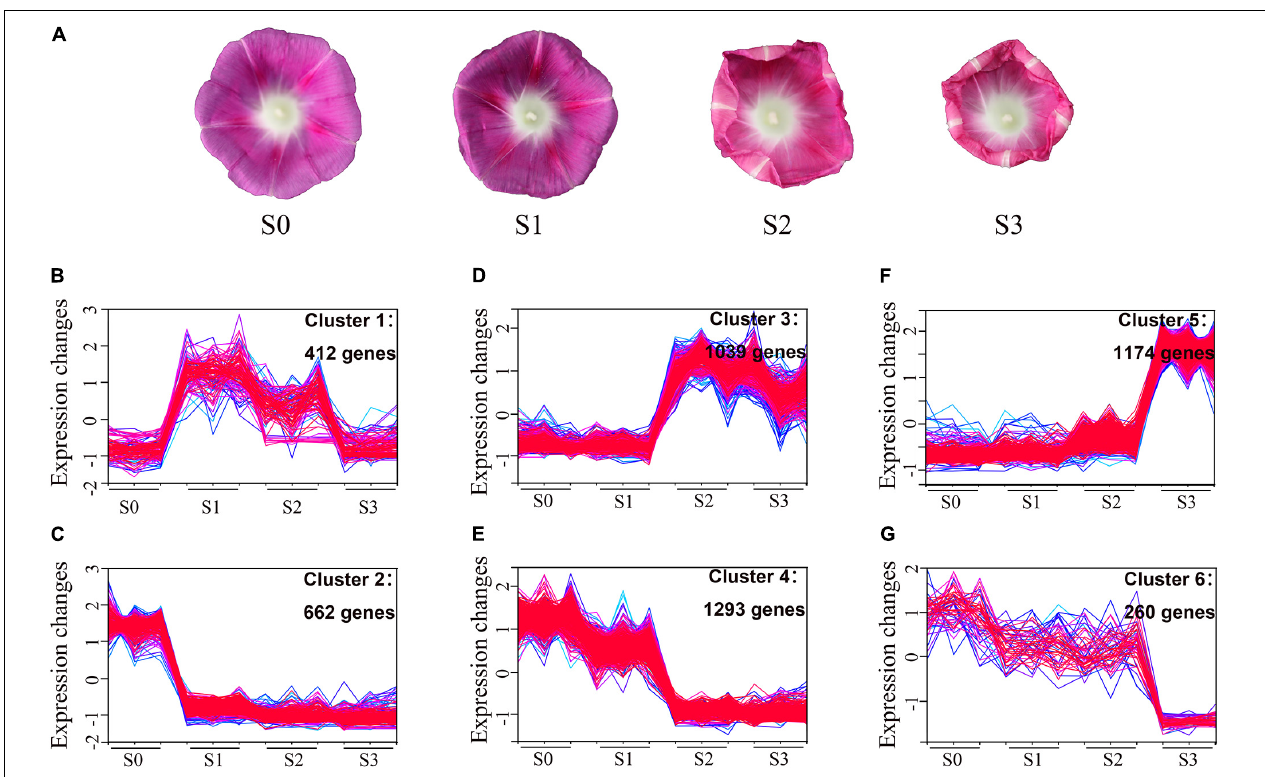
FIGURE 4 | Analysis of differentially expressed genes in six clusters during corolla closure. (A) Photographs of samples collected at different time points used for transcriptome analysis. (B–G) An overview of the different clusters. The genes differentially expressed during corolla closure at different time points (S0, S1, S2, and S3) were grouped into 6 clusters, whose gene expression patterns are